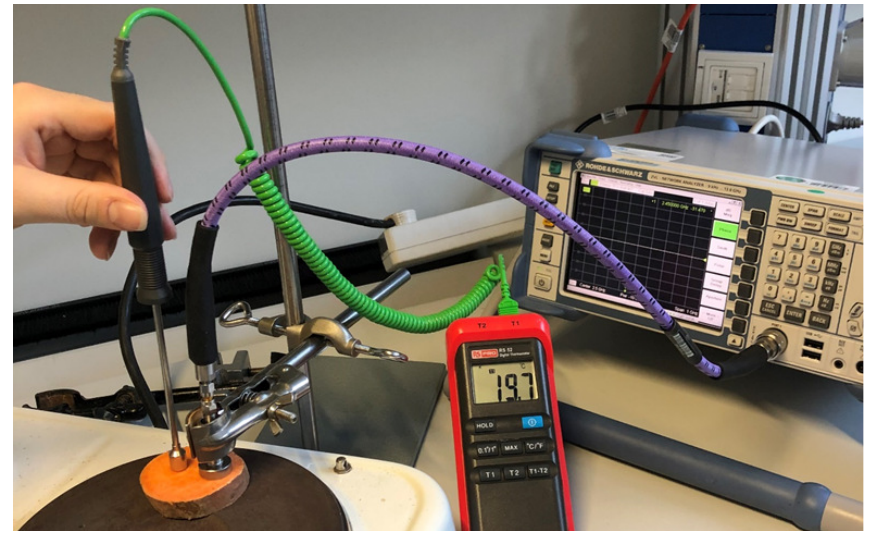
Figure 5. Experimental setup for measuring material properties of